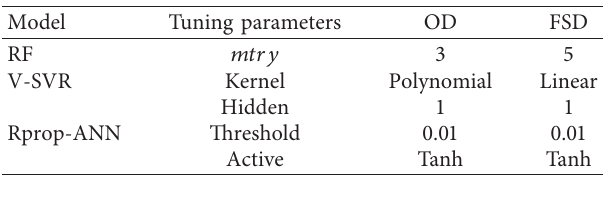
Figure 3: Flowchart of point prediction of DGSR. Table 1: Tuning parameters of each model. (blue) for the RF, V-SVR, and Rprop-ANN models in 2016.